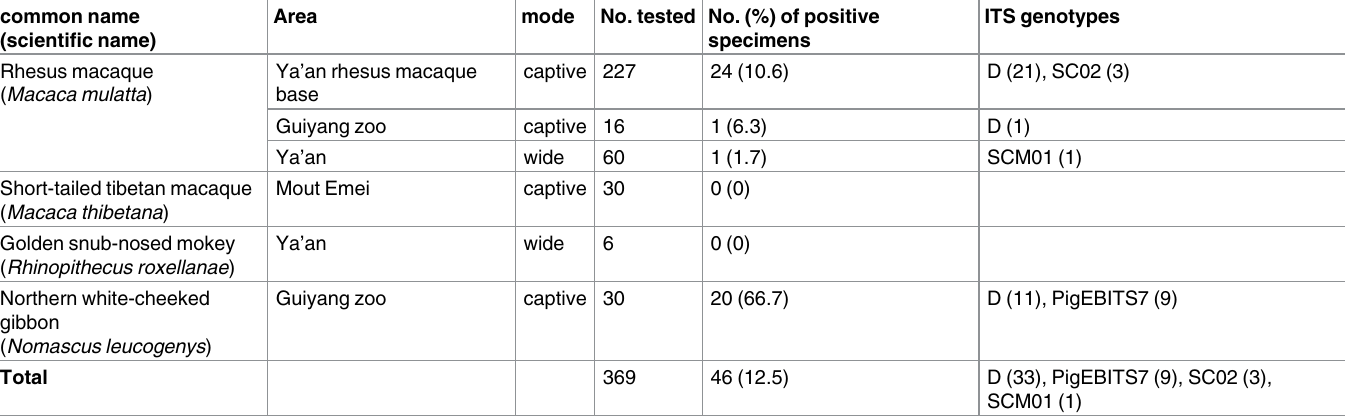
Table 1. Prevalence of Enterocytozoon bieneusi and genotypes in nonhuman primates based on PCR and sequence analysis of the ITS locus. common name (scientific